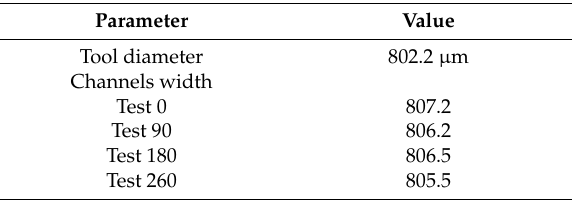
Table 4. Measured tool diameter and width of channels.